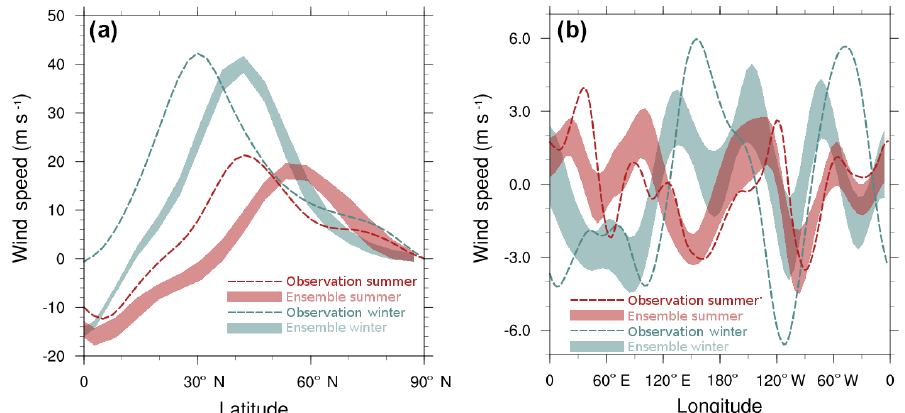
Figure 13. (a) The zonal average of the zonal component of the 200hPa wind velocity, and (b) the meridional average of the meridional component of the 200hPa wind velocity over the NH. Filled areas show the model ensemble mean and the two standard deviation range. Dashed lines represent observational data. Blue is for winter, and red is for summer.